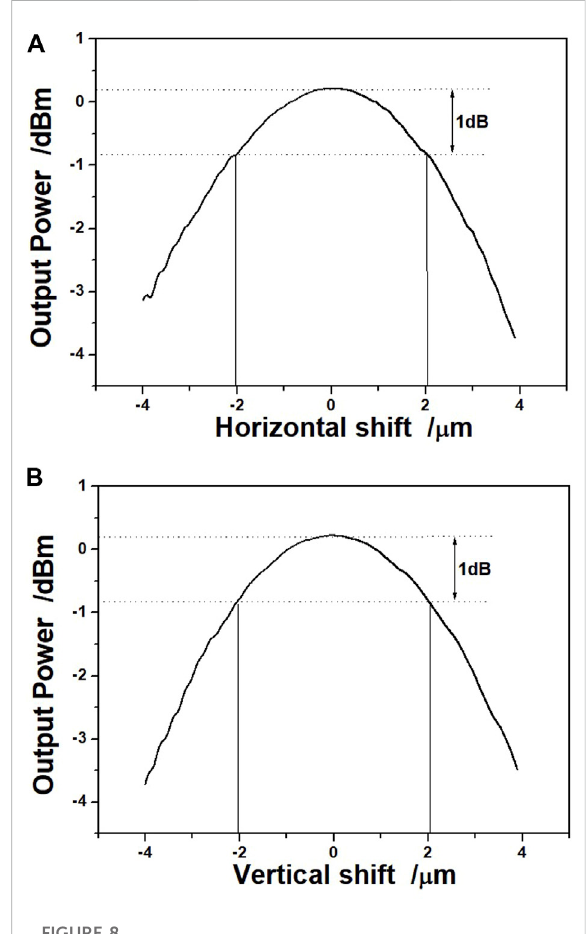
FIGURE 8 Alignment tolerance between mode size converter